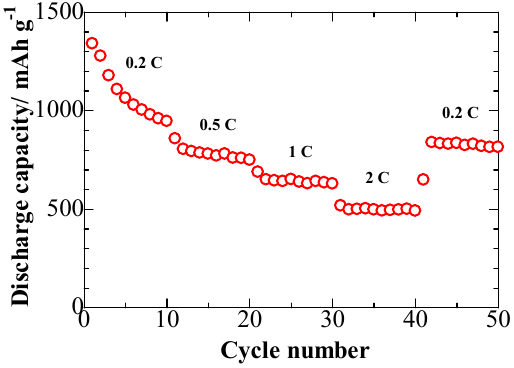
Figure 10. Rate performance of the S/GO composite electrode.